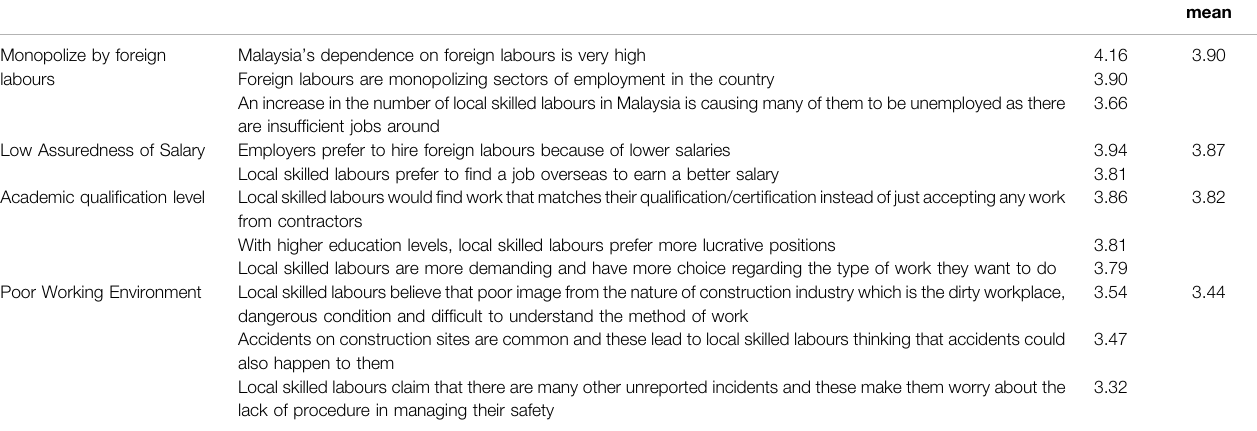
TABLE 7 | Causes of low local skilled labour participation in Malaysia ’ s construction